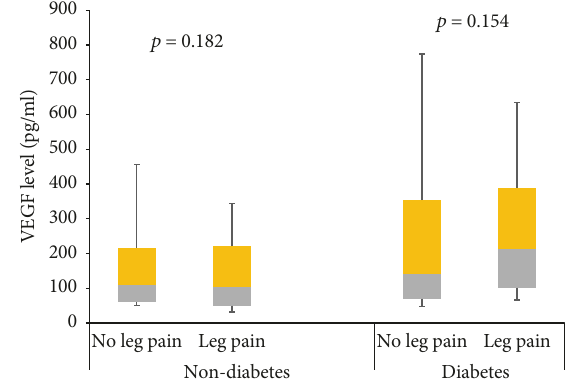
Figure 3: Circulating levels of VEGF among patients with leg pains based on their diabetes status. Data represented as median and interquartile range and analysed with Mann–Whitney